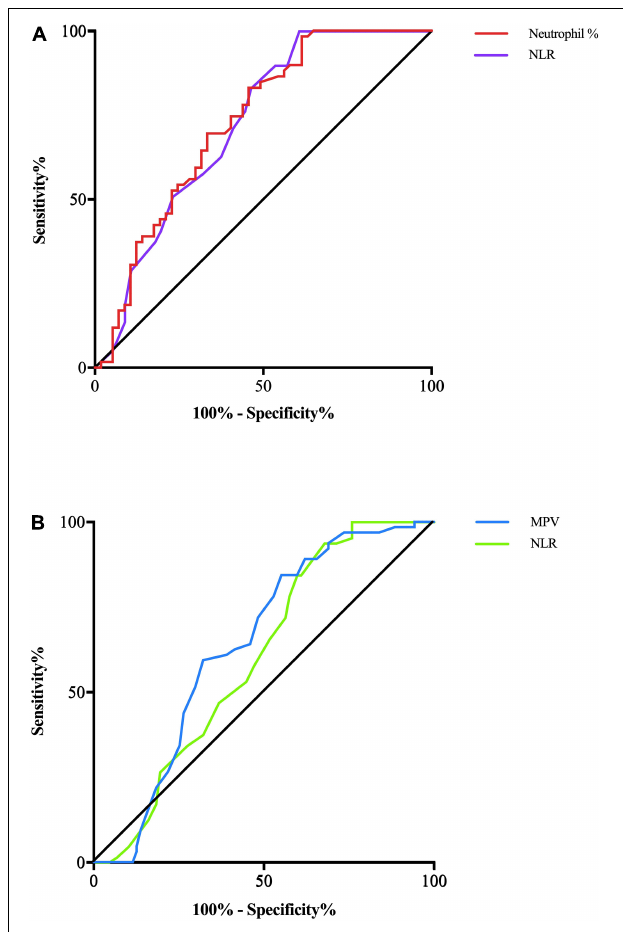
FIGURE 2 | (A) AD patients and CTRs are differentiated by the NLR with a predictive power (AUC) of 0.721 (violet line) and by the neutrophil% with a predictive power (AUC) of 0.728 (red line). (B) MCI patients and CTRs are differentiated by the NLR with a predictive power (AUC) of 0.601 (green line) and by the MPV with a predictive power (AUC) of 0.690 (blue